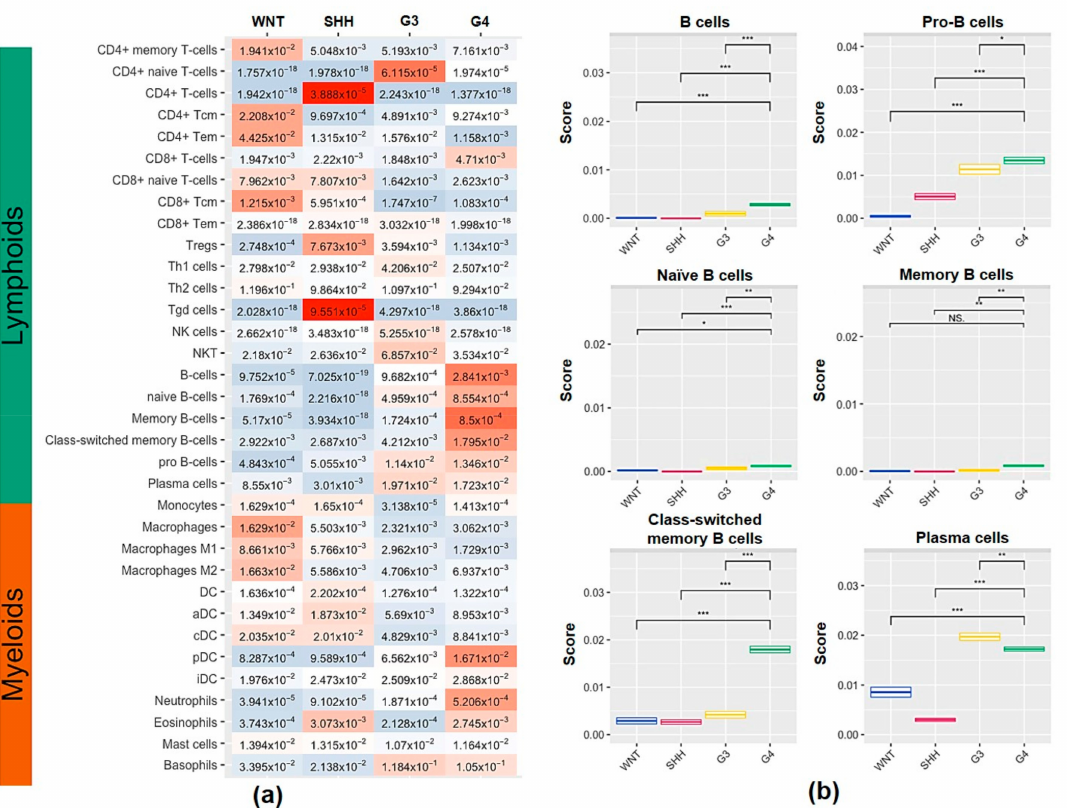
Figure 2. Analysis of immune cells and B cell subsets from the SickKids cohort study. ( a ) The distri- bution of lymphoid and myeloid enrichment from the SickKids cohort study ( n = 763). Expression values are represented as colors and range from red (high), white (moderate) to light blue (low). ( b ) The expression of the infiltrating B cells subsets from in MB subgroups. *, p < 0.05; **, p < 0.01; ***, p < 0.001, compared to G4 subgroup tumors. NS: no significant